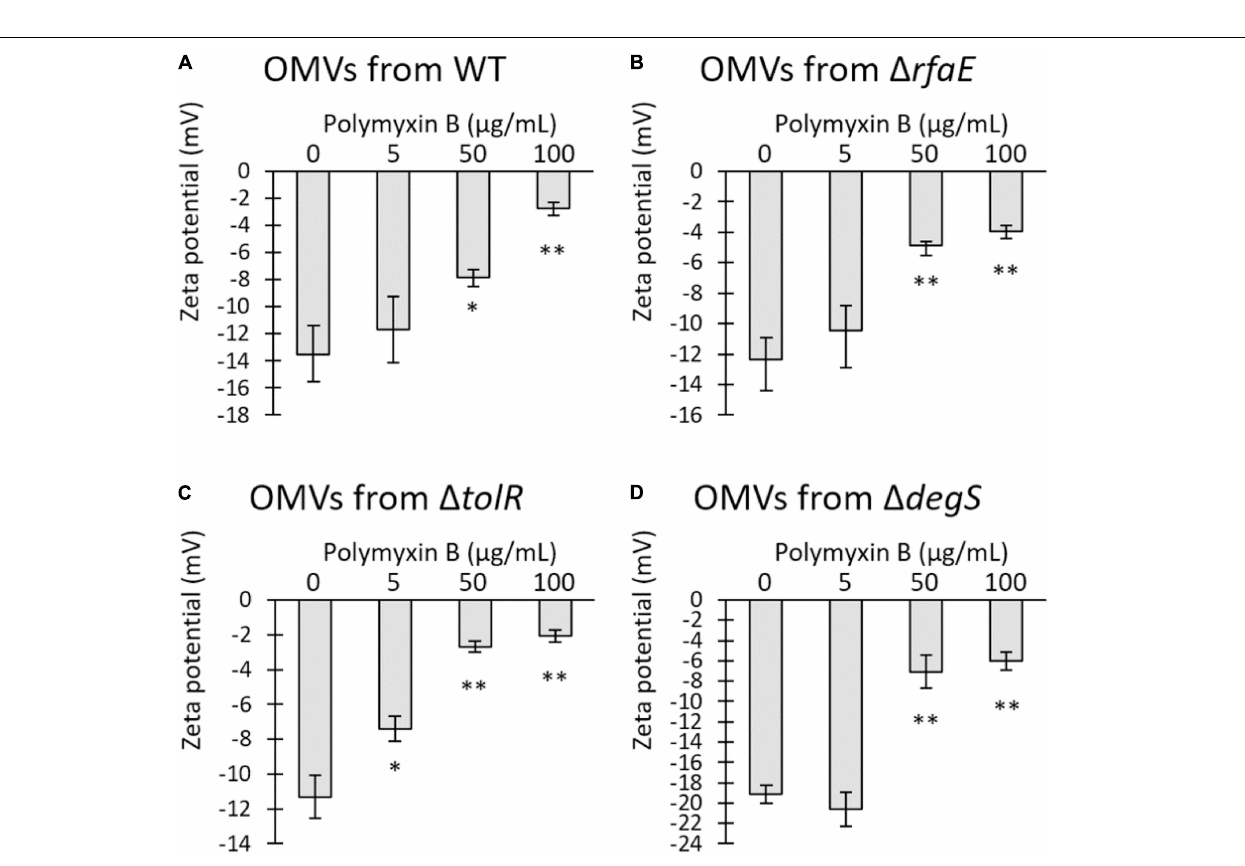
FIGURE 4 | Polymyxin B interacts with OMVs from S. Typhi, depolarizing the Zeta potential of OMVs. Increasing concentrations of polymyxin B were mixed with 50 µ g/mL OMVs obtained from S. Typhi WT (A) , (cid:49) rfaE (B) , (cid:49) tolR (C) , or (cid:49) degS (D) . The mixture was incubated for 30 min at 37 ◦ C and ultrafiltered to remove the unbound polymyxin B prior to determining the Zeta potential. (n = 3, bars represent standard error, One-way ANOVA, Tukey as a post hoc test, ∗ p < 0.05; ∗∗ p < 0.01; compared the control with no polymyxin B).